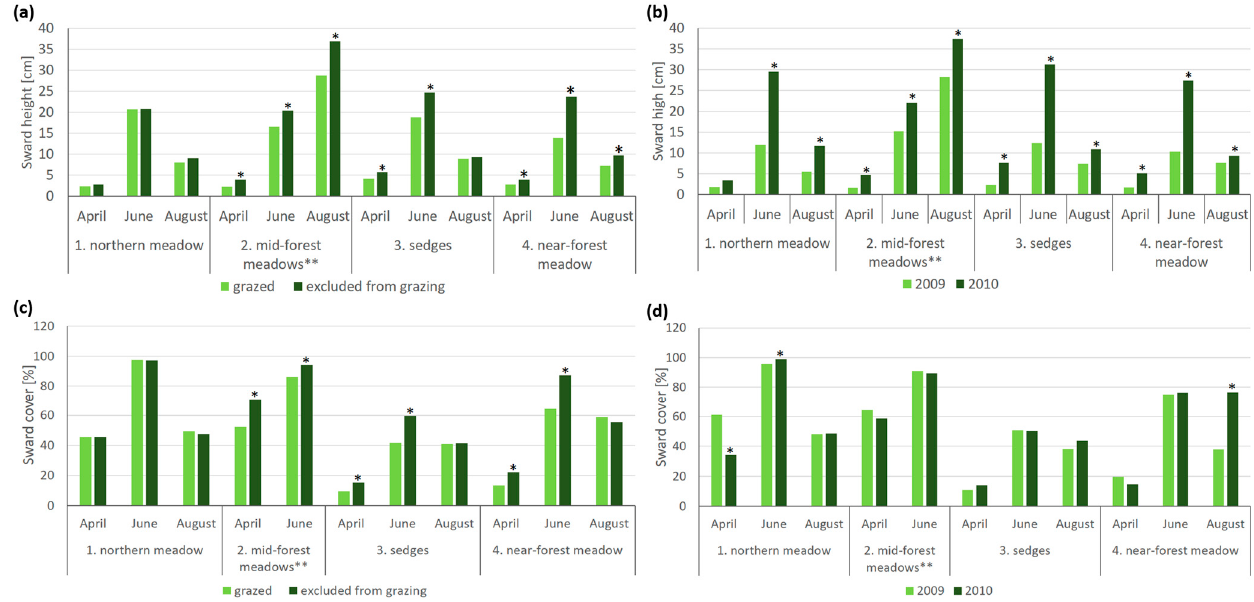
Figure 5. Average sward height [cm] ( a , b ) and sward cover [%] ( c , d ) in grazed and ungrazed sites in years 2009–2010. Tests were performed for each factor separately; * indicate a significant differ- ence, p ≤ 0.05; ** mid-forest meadows have not been mowed in 2009 and 2010; no variability in the results of the sward cover in August unable statistical analysis for the mid-forest meadows.